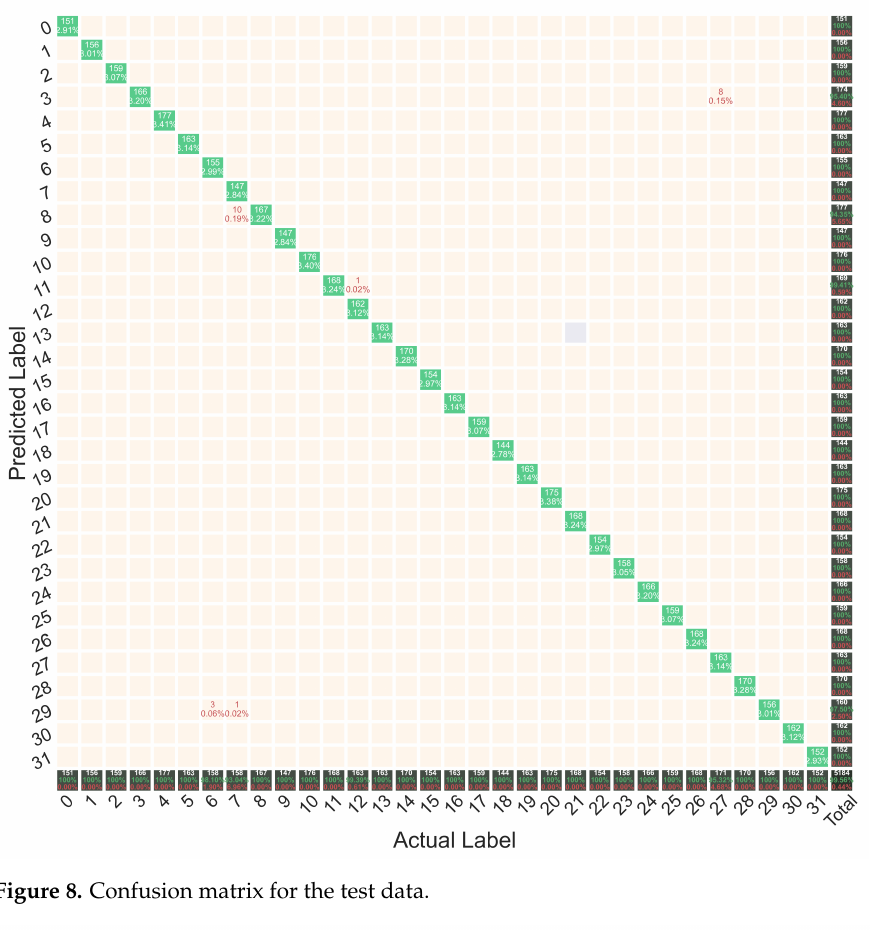
Figure 8. Confusion matrix for the test data.